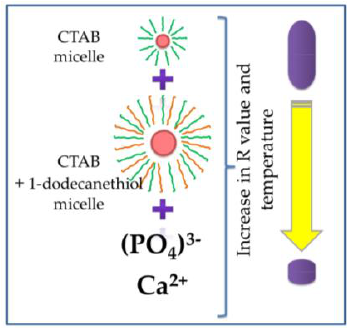
Figure 1. Scheme showing the morphological changes of hydroxyapatite (HAp) induced by the increase of temperature and the change of R ratios. CTAB for cetyltrimethylammonium bromide. Adapted from [11], Elsevier, 2016.